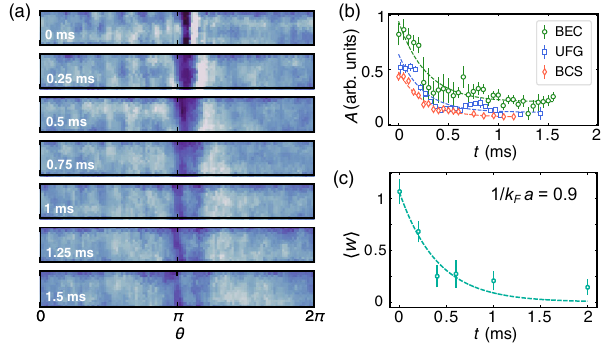
FIG. 10. Short-timescale dynamics after the imprinting. (a) Time evolution of the in situ density profile of a BEC ≃ 2 π imprinting. Each image consists of an superfluid after a Δ ϕ I average of 10 absorption images, changed into polar coordinates. (b) Amplitude of the density depletion as a function of time after the suited imprinting pulse to populate the w ¼ 1 state in the three interaction regimes (see legend). Each data point corresponds to the fitted value and 1 σ uncertainty from a gaussian fit of the integrated density. For UFG and BCS they are obtained from the analysis of the in situ superfluid density with no magnetic field sweep. Each curve is fitted with an exponential function provid- ing a decay time of τ ¼ f 0 . 28 ð 5 Þ ; 0 . 25 ð 5 Þ ; 0 . 25 ð 3 Þg ms in the BEC, UFG and BCS regime, respectively. (c) Short-time dy- namics of the average winding number and its SEM after an 2 π in a strongly interacting superfluid at imprinting of Δ ϕ I ¼ 1 =k a ≃ 0 . 9 , measured from the interferograms acquired at the F same interaction strength. The dashed line represents an expo- nential fit of the data with τ ¼ 400 ð 80 Þ μ